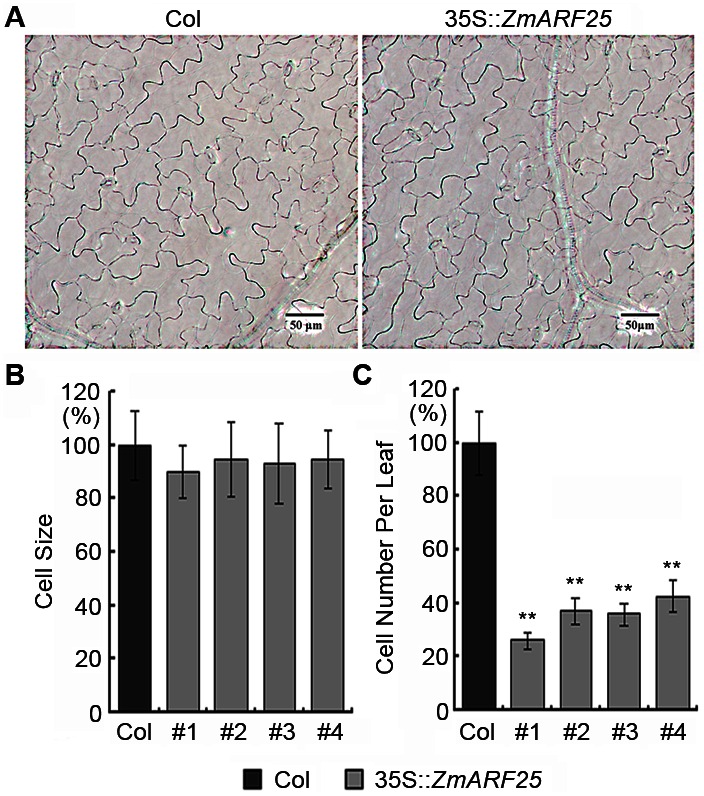
Histological analysis of fully expanded fifth leaves of 35S::ZmARF25 and wild-type plants.(A) Epidermal cells of the fully expanded fifth leaves of 35S::ZmARF25 and wild-type plants. The statistics of (B) epidermal cells size and (C) cell number per leaf. Fully expanded fifth leaves of wild-type transgenic plants were analyzed. Data are represented as the mean ± SE (n = 10). t-test compared with the wild-type control: **refers to significant at p<0.01.